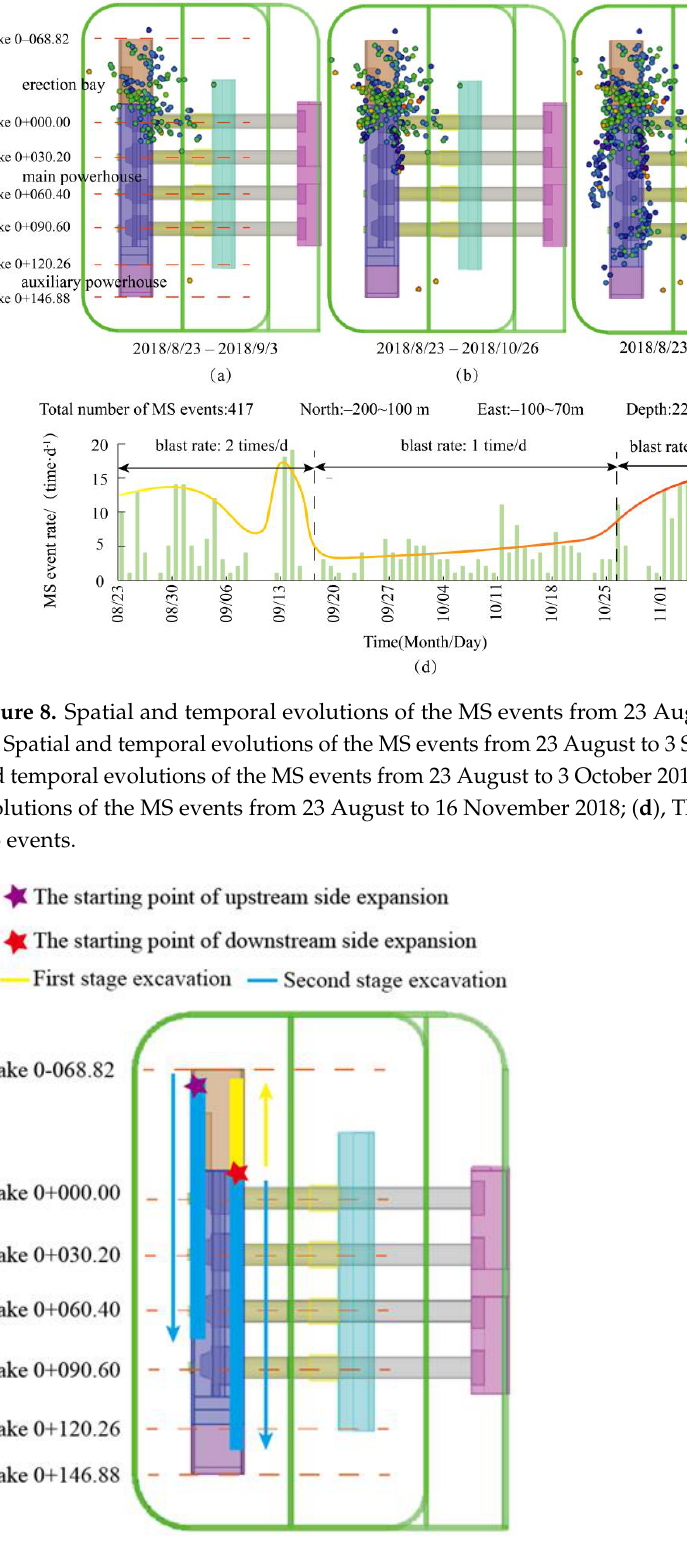
Figure 9. Excavation sequence of the